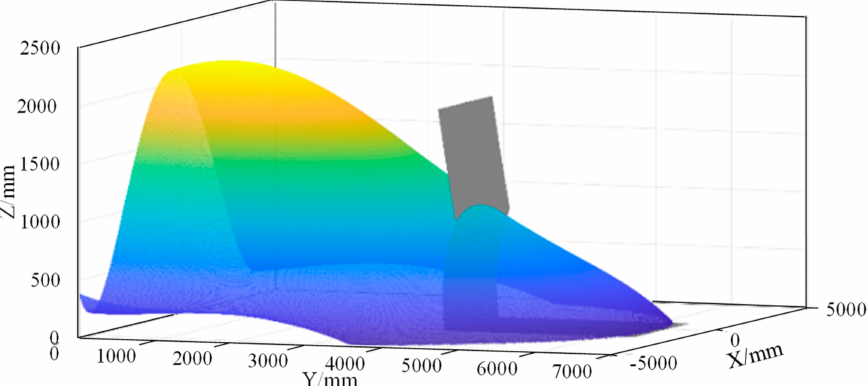
Figure 9. The integration area between the material surface profile and the shovel trajectory.